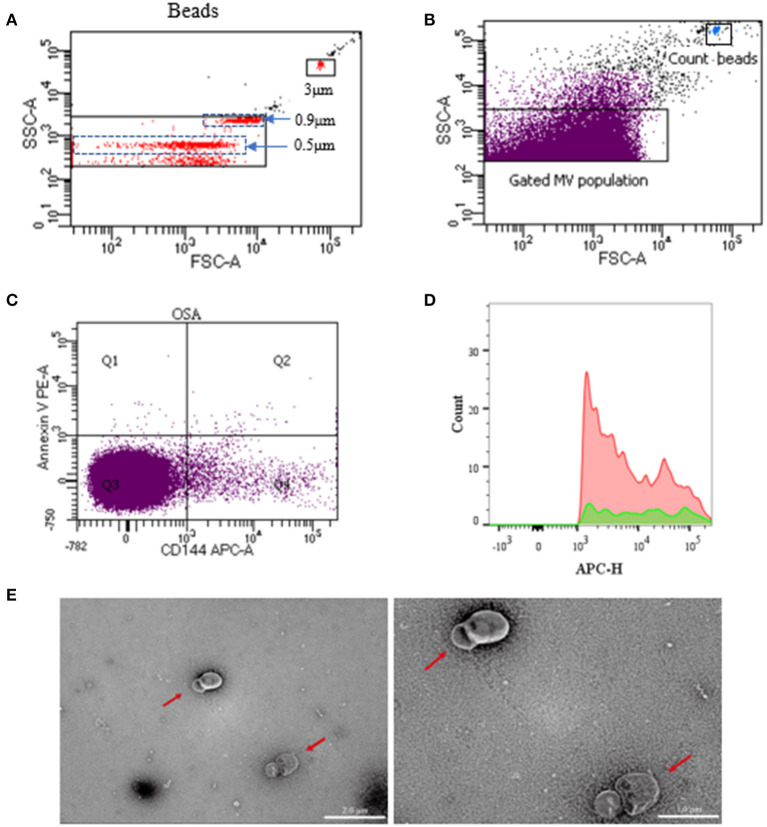
Representative dot plots of flow cytometry for circulating MVs. Overview of gating strategy of MVs in the plasma. Microbeads of 0.5, 0.9, and 3 μm in diameter were used for gating MVs. (A) Once the MV gate was determined, it would not be changed. Then, without microbeads, MVs in specimens were gated and analyzed. (B) Gated MV population in the plasma and dot plots of count beads in the sample. (C) Representative dot plots of dual-labeled EMVs (Section Q2). (D) Representative dot plots of positive single-labeled EMVs. (E) Transmission electron microscopy of MVs (the red arrow). The ruler at the left measures 2 μm, and the ruler at the right measures 1μm. MVs, microvesicles; EMVs, endothelial microvesicles.